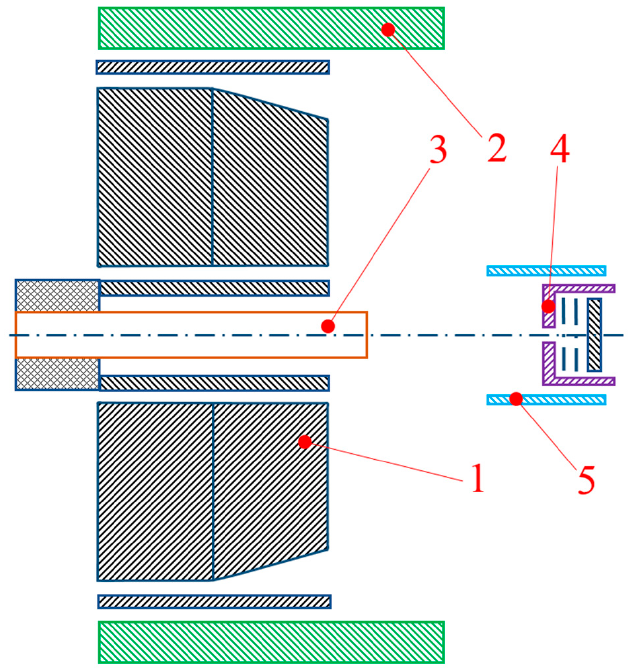
Figure 2. Scheme of multigrid probe [67]. 1—cathode, 2—passive anode, 3—evaporable anode, 4—probe (energy analyzer), 5—screen.